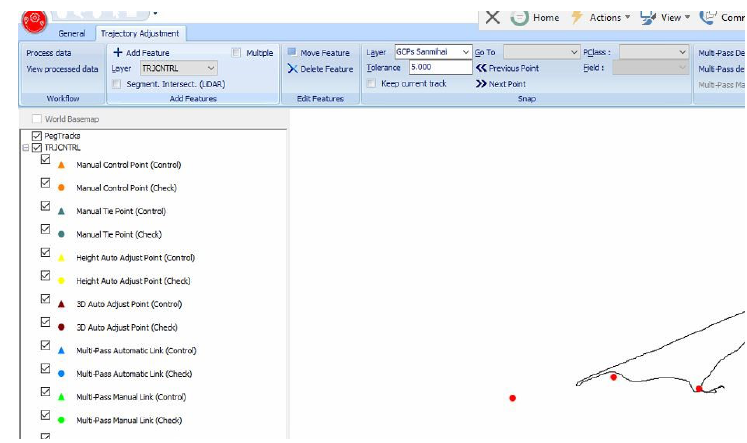
Figure 31. LiDAR measurement trajectory control.